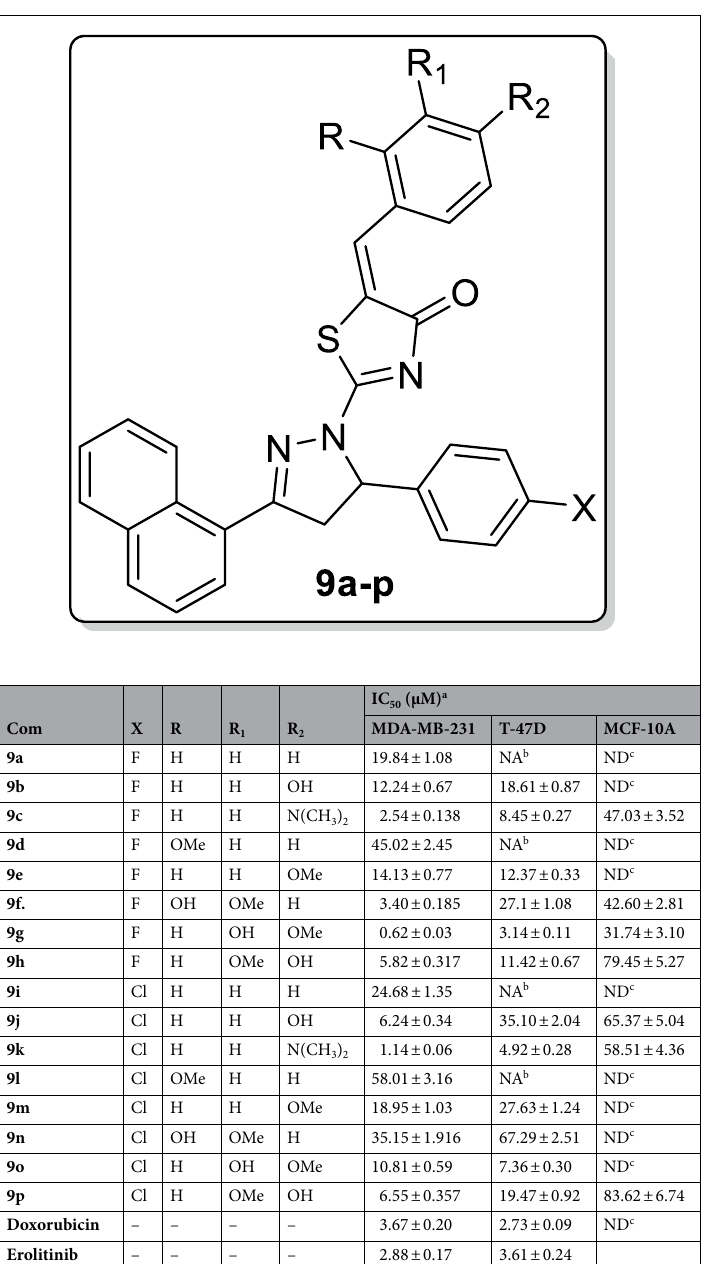
good activity as EGFR inhibitors in nanomolar concentrations (IC 50 = 267 ± 12 and 395 ± 17 nM, respectively). Cell cycle analysis. In this work, MDA-MB-231 cells were treated with the most cytotoxic members (com- pounds 9g and 9k ) at a concentration of 0.62 and 1.14 µM, respectively (corresponding to their IC 50 values against MDA-MB-23 cells). Investigating the results, it can be noticed that compounds 9g and 9k induced a sig- nificant increase in the cell population at Sub-G1 phase (31.05% and 27.86%, respectively), comparing to control